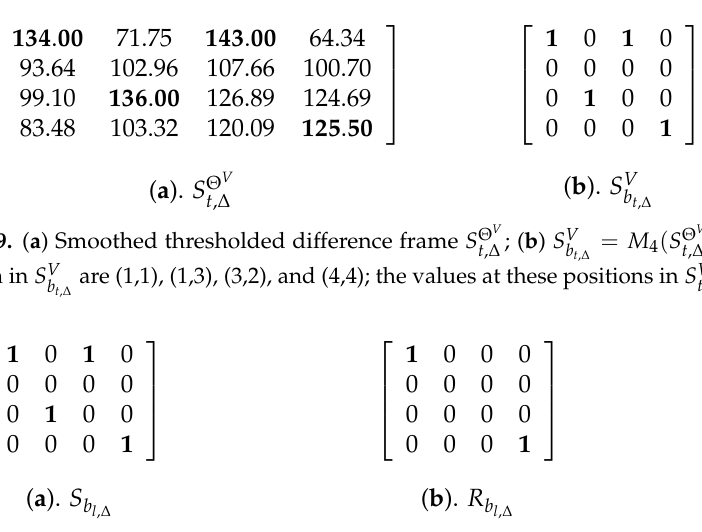
Figure 10. ( a ) Binary difference frame S b (( 1,1 ) , ( 1,3 ) , ( 3,2 ) , ( 4,4 )) and d V =